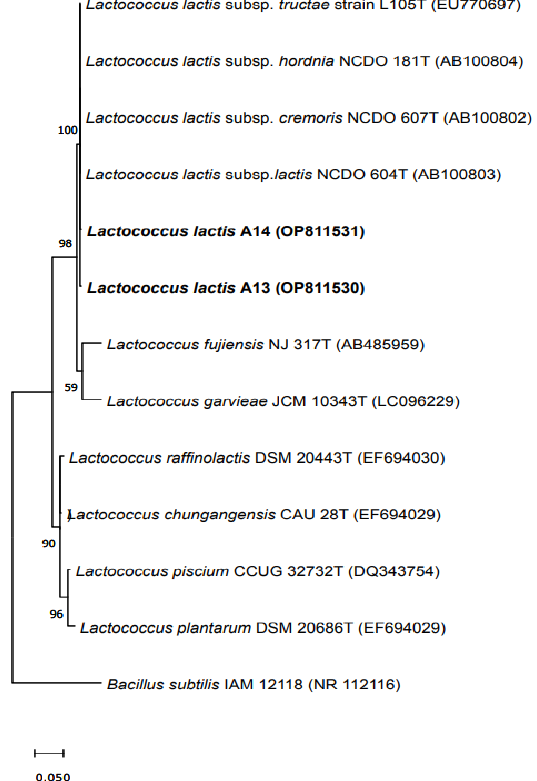
Figure 2. Maximum likelihood tree based on 16S rRNA sequences showing the phylogenetic analysis of the studied L. lactis isolates (bolded). Bootstrap values >50% are indicated. The scale bar displays the number of nucleotide substitutions per site. The sequence of Bacillus subtilis was used as an outgroup.